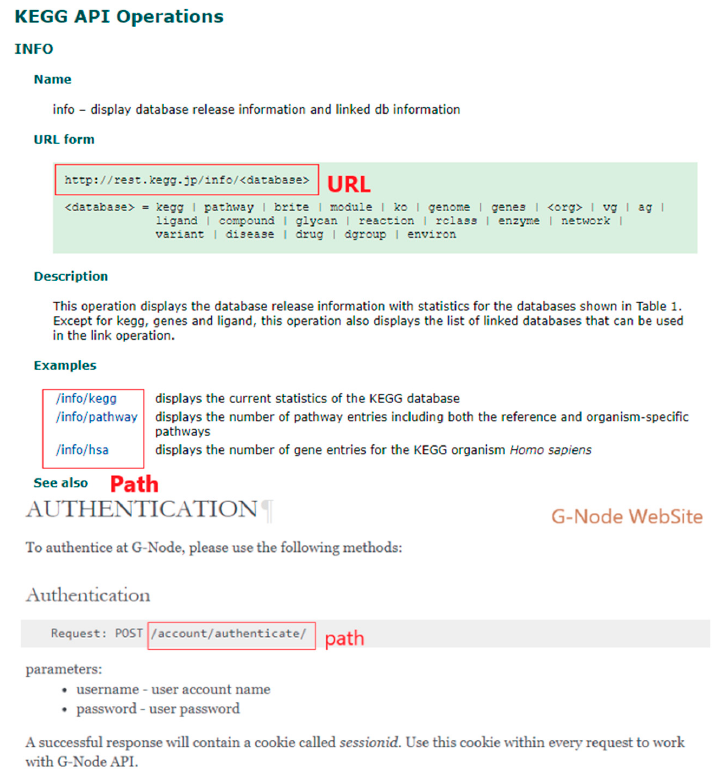
Figure 2. Example of Kyoto Encyclopedia of Genes and Genomes (KEGG) and German Neuroinformatics Node (G-Node) RESTful description. Table 1. Details of Feature Pattern Search and Replace (FPSR).